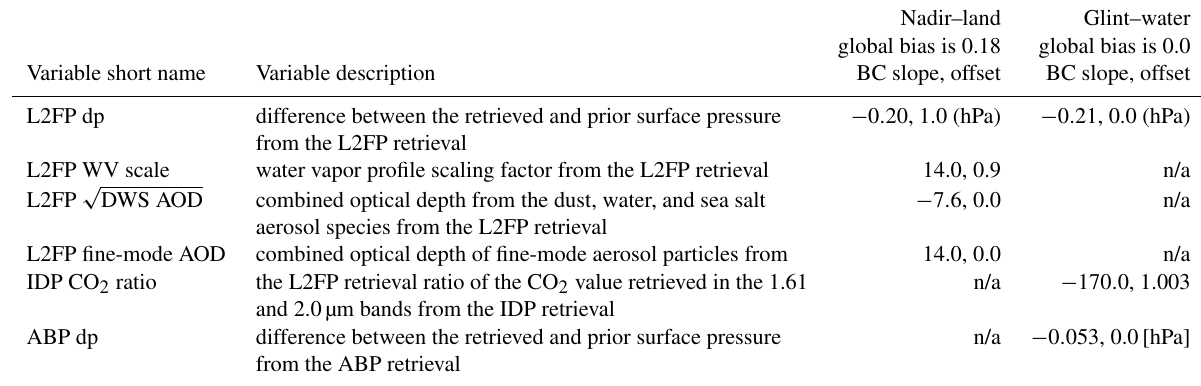
Table 4. Bias correction parameters for the OCO-3 simulation. Only the prior (dp) terms have units (hPa), while the other parameters are unitless. Again, the need for a water vapor scaling factor bias correction term is likely due to an indexing bug in the L1b simulator code. The “DS” AOD is the combined optical depth of dust and sea salt aerosols.